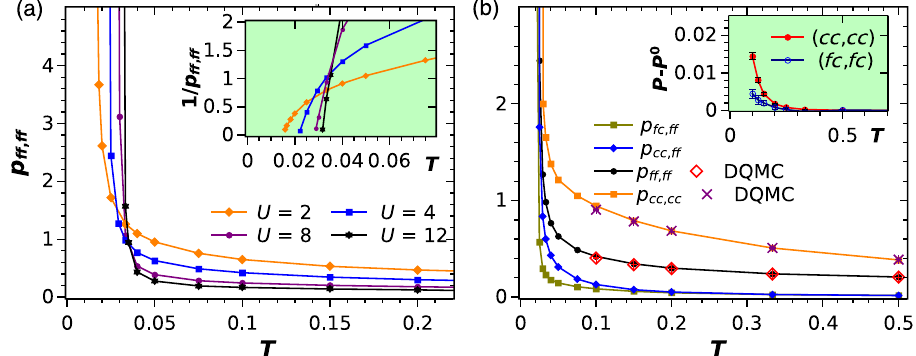
FIG. 2. d pairing susceptibility as a function of temperature from DCA calculations on 2 × 2 × 2 clusters. (a) ( ff; ff ) channel for x 2 − y 2 U ¼ 2 ; 4 ; 8 ; 12 at constant V 2 =U and V 0 ¼ 2 . 5 V . The inset shows that the inverse pairing susceptibilities extrapolate to zero, signaling that T increases with U . (b) Comparison of different channels for V ¼ 0 . 3 , V 0 ¼ 0 . 75 , and U ¼ 4 . Available DQMC results at large T , c shown by crosses and open diamonds, are in excellent agreement with those of DCA. The inset shows the effective pairing interaction in the ð cc; cc Þ and ð fc; fc Þ channels calculated by DQMC. They are small compared to their ð ff; ff Þ counterpart shown in the inset of Fig.